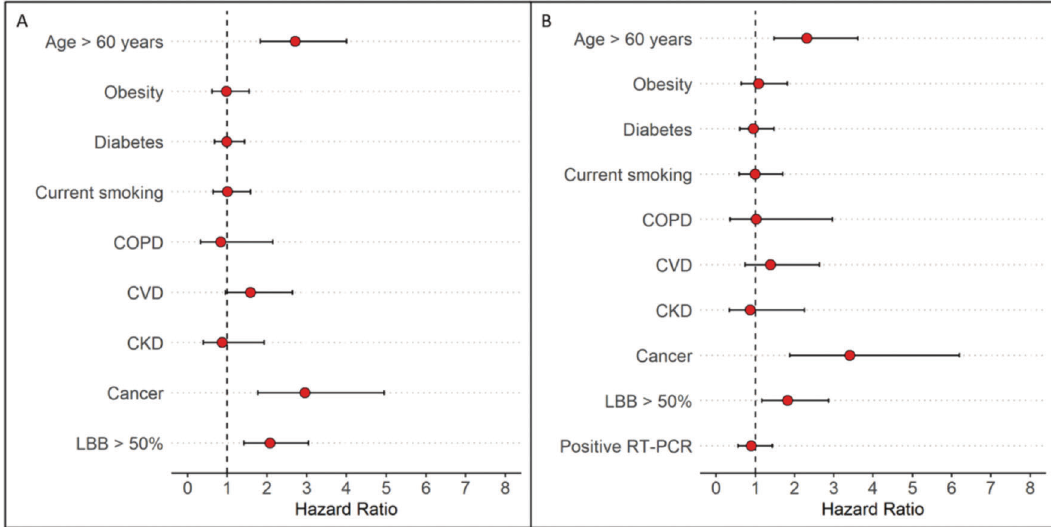
Figure 2 - A) Cumulative incidence plots for the three possible outcomes (mortality, discharged, and continued hospitalization) according to the LLB. B) Chest CT illustrating an LLB of o 50% (left images) and LLB of 4 50% (right